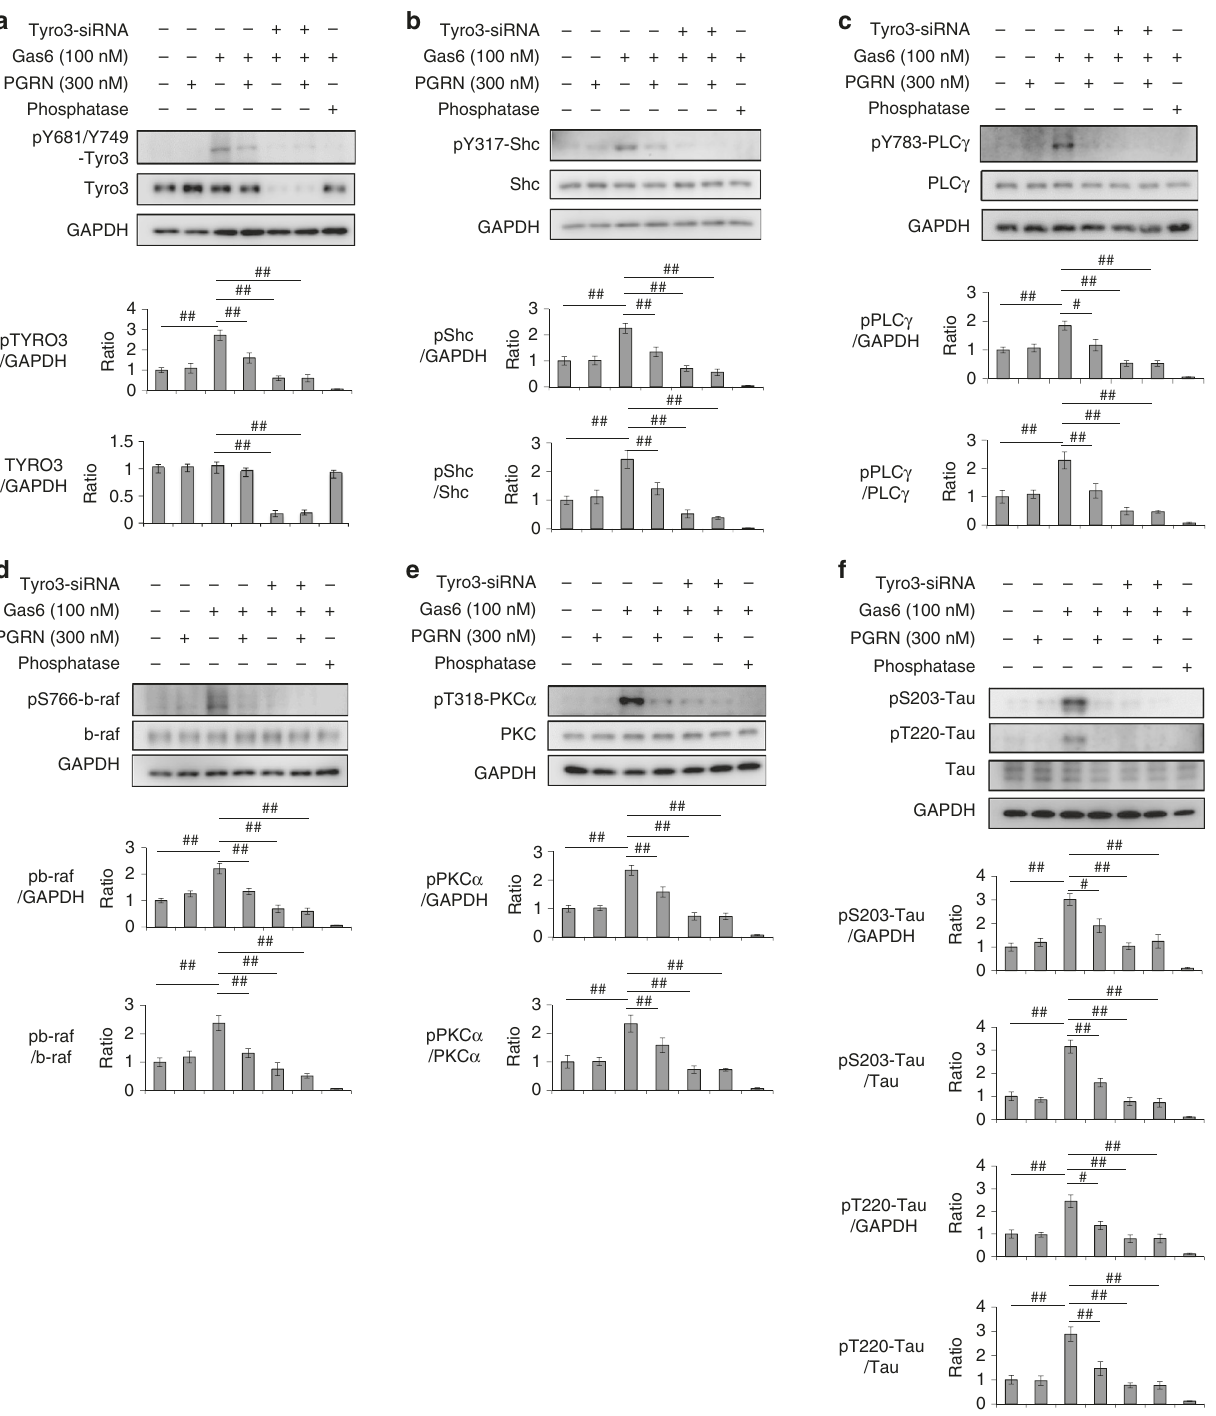
Fig. 4 Tyro3 mediates Gas6-induced signal to tau phosphorylation. Western blot analyses of the effect of siRNA-mediated knockdown of Tyro3 on phosphorylation of Tyro3 ( a ), Shc ( b ), PLC γ ( c ), B-Raf ( d ), PKC α ( e ), and tau ( f ). SiRNA-mediated knockdown of Tyro3 exerted suppressive effects on activation of Shc ( b ) and PLC γ ( c ), as well as on phosphorylation of tau at Ser203 and Thr220 ( e ). # p < 0.05; ## p < 0.01 ( N = 5, Tukey ’ s HSD test). Averages and s.e.m. are shown. Phosphatase treatment of the samples substantially decreased the western blot band intensities of phosphorylated Tyro3 ( a ), Shc ( b ), PLC γ ( c ) B-Raf ( d ), PKC α ( e ), and Tau ( f ). p -values are shown in Supplementary Data